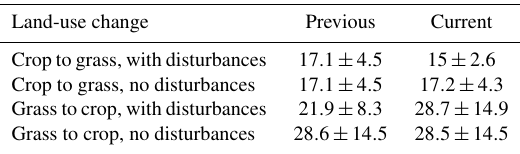
Table 6. Mean soil carbon turnover time (years) for the previous and current land use for the jsb_drvn simulation with and without